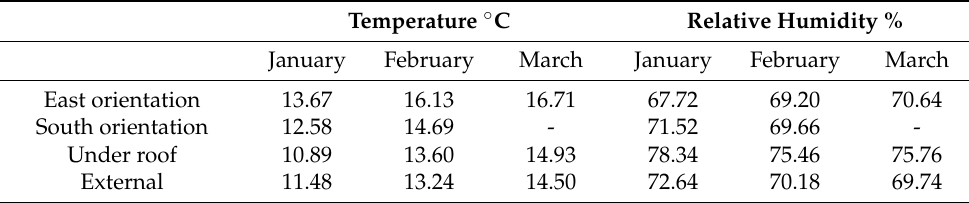
Table 1. Recorded data for calibration and validation of the model. Average monthly values for temperature and